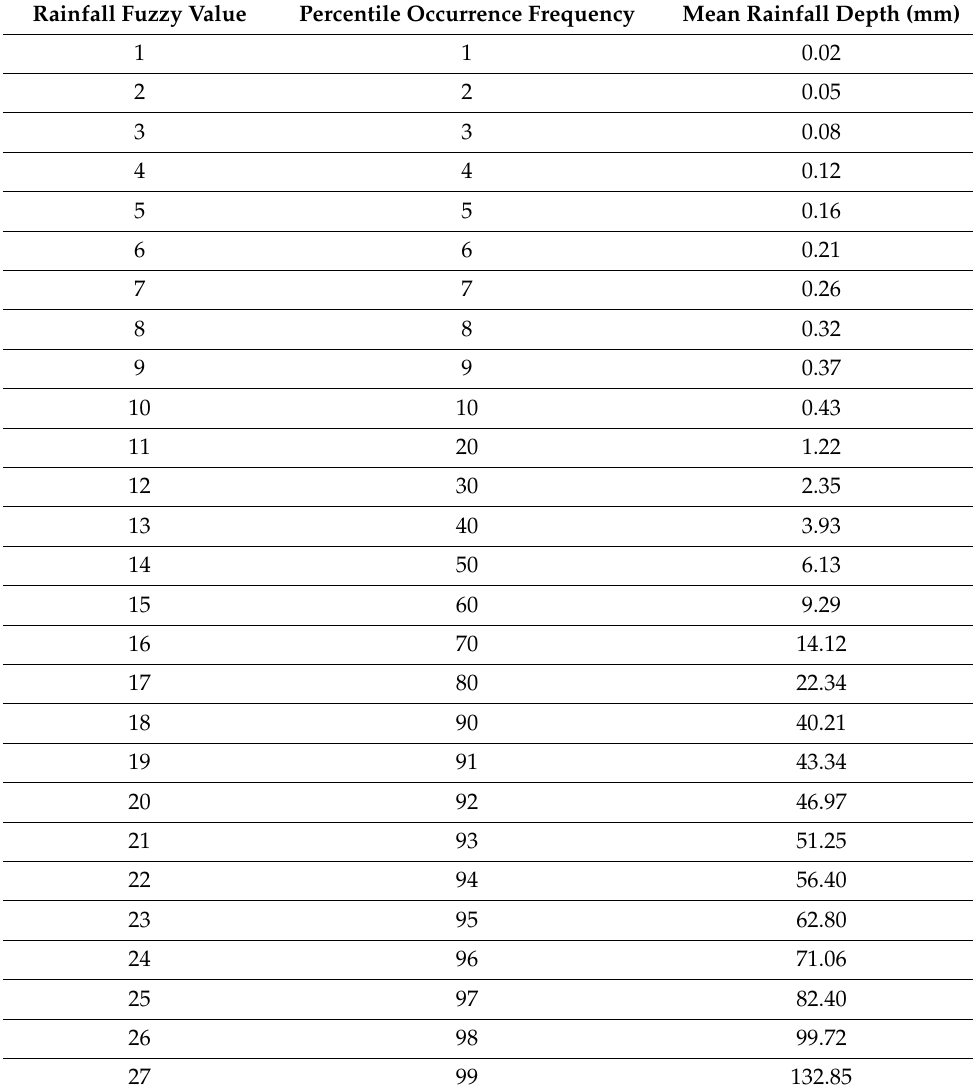
Figure 4. Rainfall Fuzzy Values. Table 4. Percentile Occurrence Frequency.